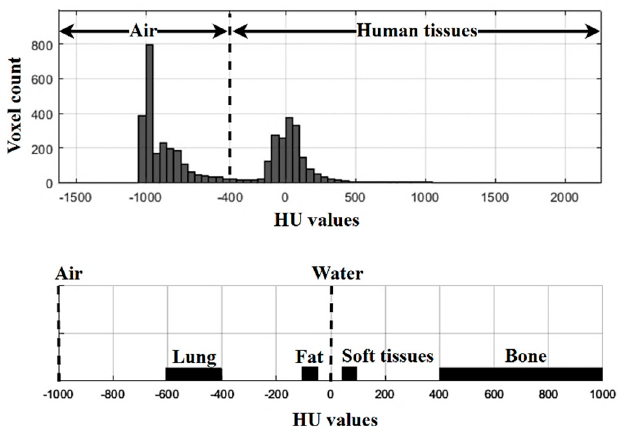
Figure 3. The range of radiological density of the lung structures.